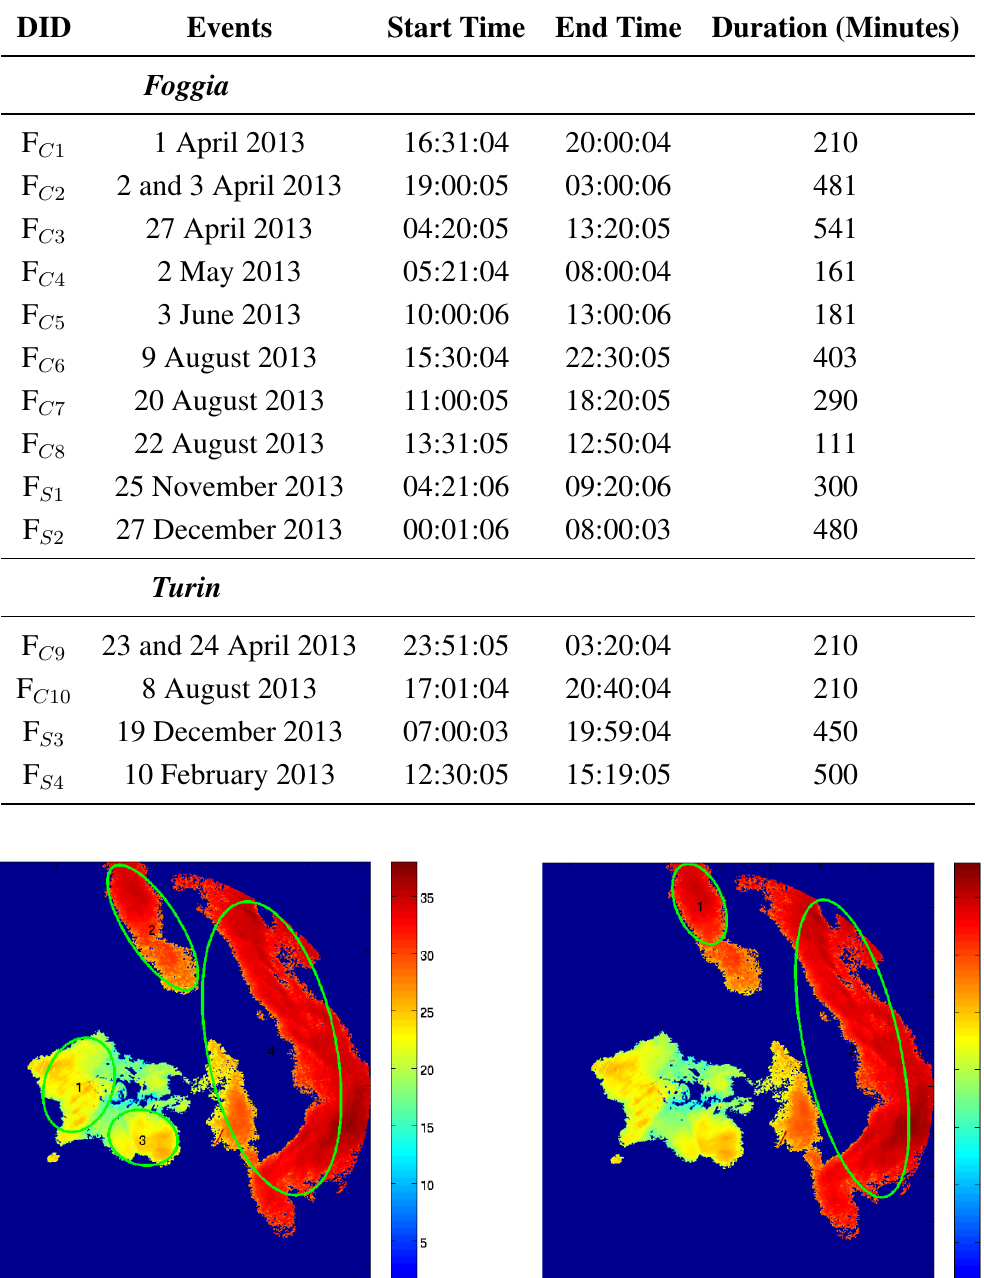
Table 1. Selected datasets; F = Foggia, T = Turin, C = convective, S= stratiform and DID = dataset ID.